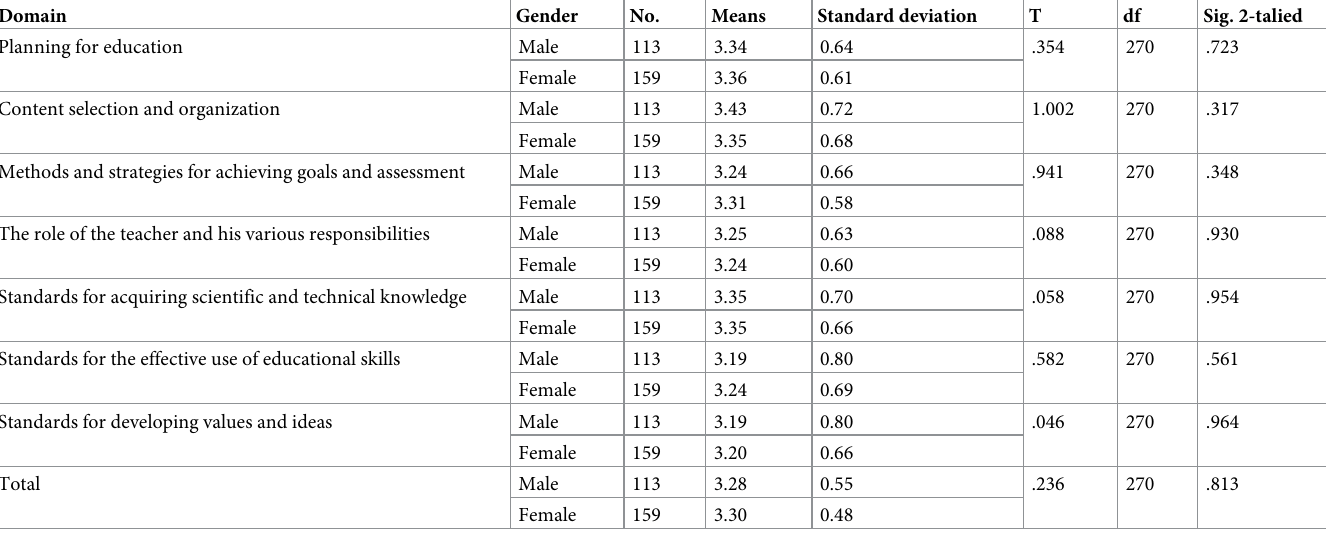
Table 5. T-test analysis for the quality assessment of the training programs for students with disabilities in light of modern trends attributed to gender.